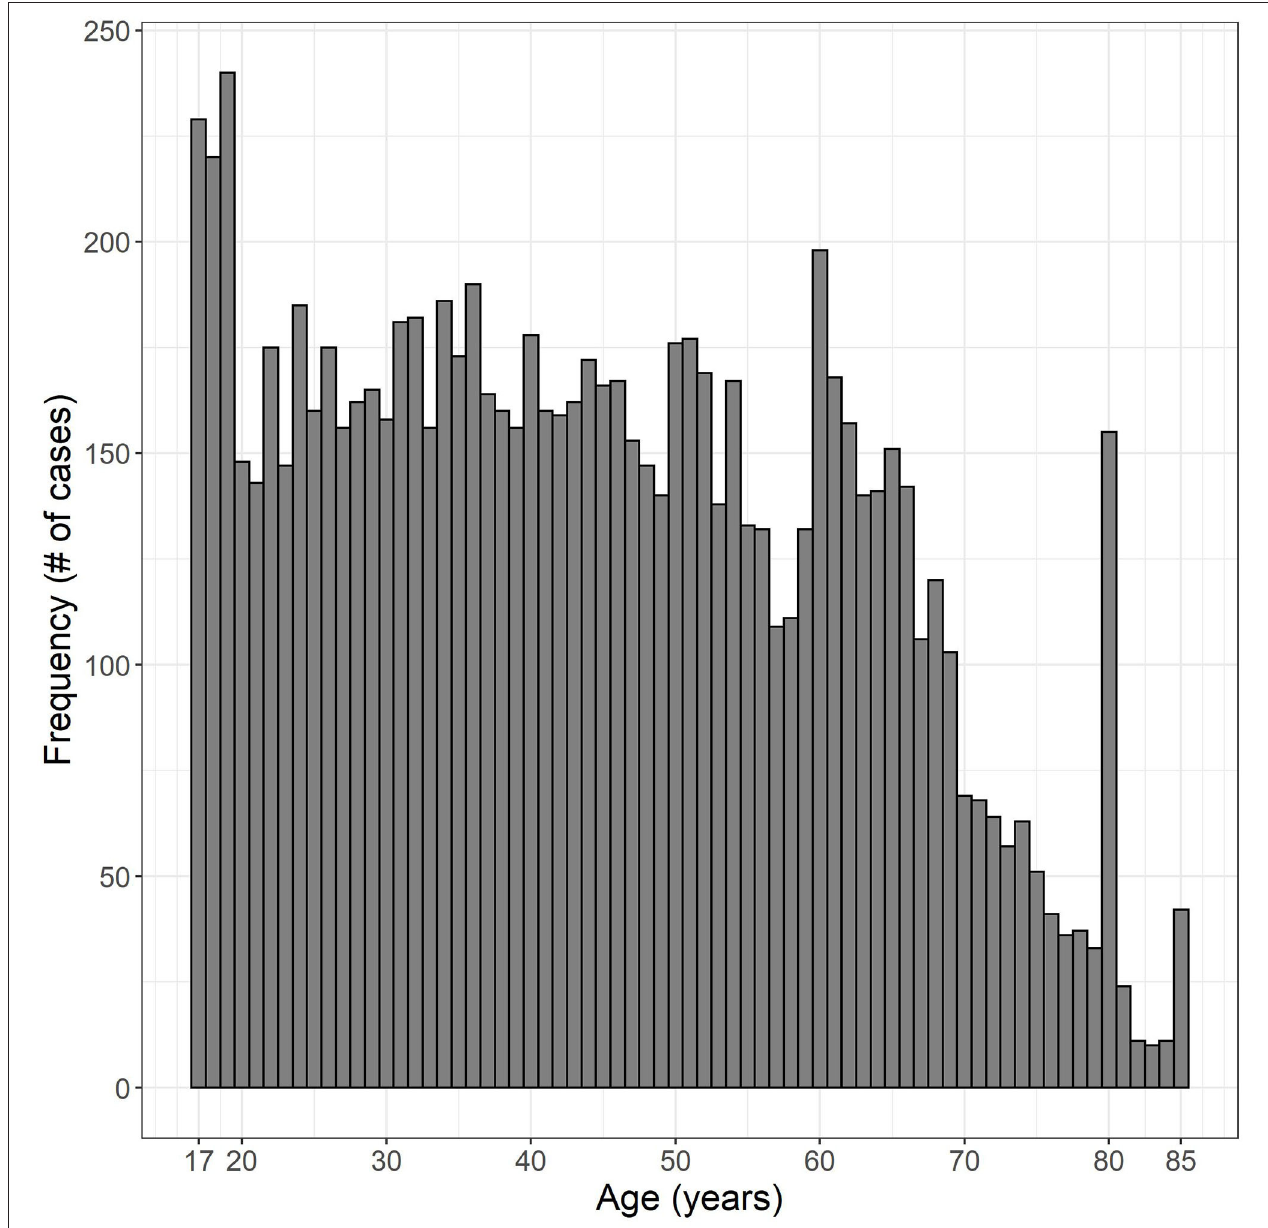
FIGURE 2 | Histogram of ages examined. Data were obtained from the National Health and Nutrition Examination survey.